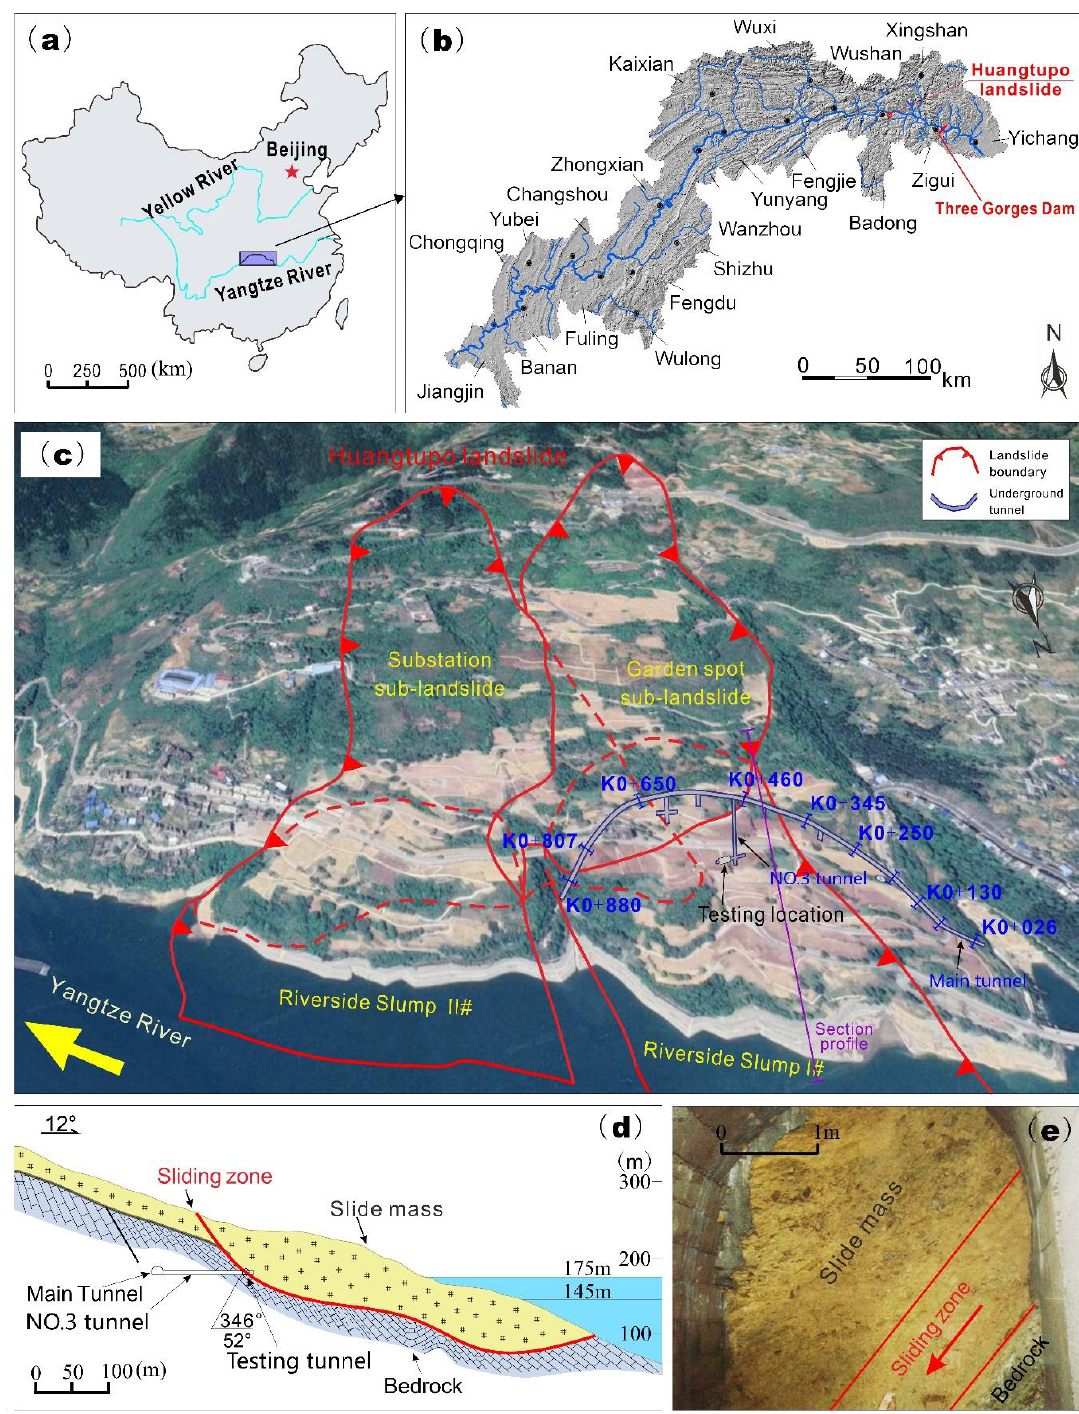
Figure 1. ( a , b ) show the location of the Huangtupo landslide; ( c , d ) are the map and profile section, respectively, of the Huangtupo landslide; ( e ) is the face of the testing tunnel where the in situ shear tests were conducted.